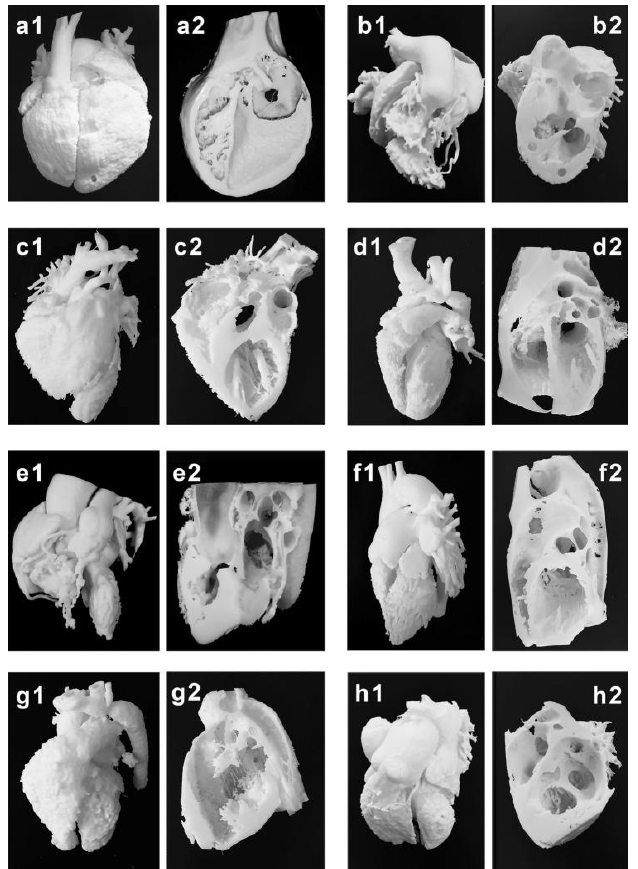
Figure 3. Three-dimensional printing of the blood pool and myocardium (showing inside views of cardiac structures at different angles) models for eight typical CHD cases ( a – h ). ( a1 – h1 ) are blood pool models, while ( a2 – h2 ) are myocardium models showing internal cardiac structures. Case 1: congenital corrected transposition of the great arteries. Case 2: double outlet right ventricle. Case 3: Williams syndrome. Case 4: coronary artery fistula. Case 5: Tetralogy of Fallot. Case 6: patent ductus arteriosus. Case 7: coarctation of the aorta. Case 8: ventricular septal defect. Reprinted with permis- sion under the open access from Liang et al. [38].